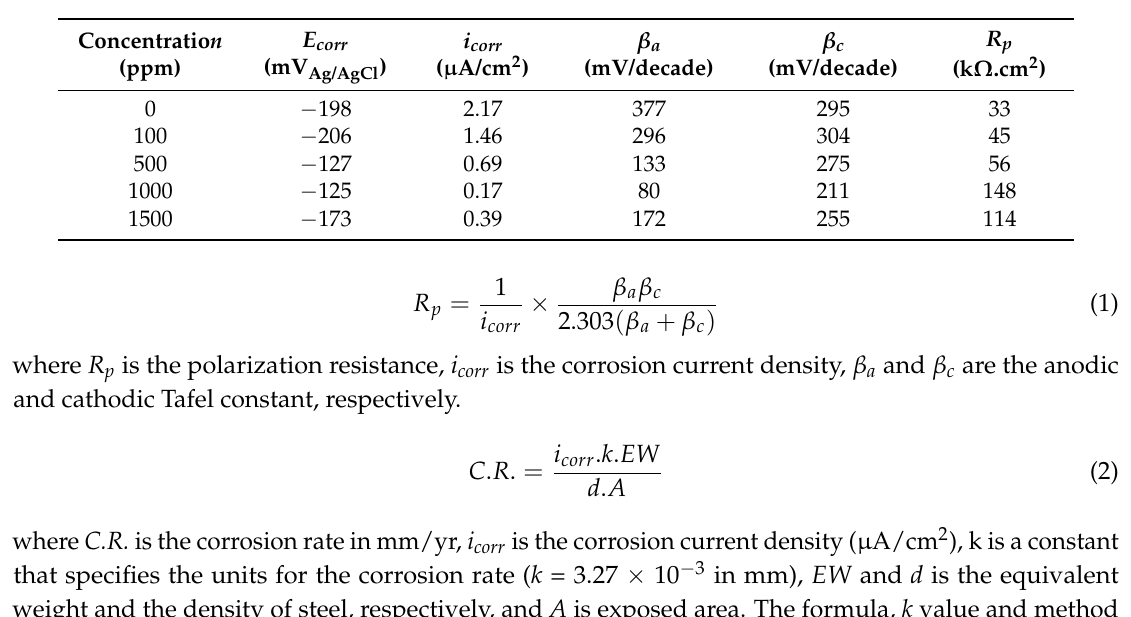
Figure 5. ( a ) Potentiodynamic polarization curves; and ( b ) effect of APL-EAE concentrations on the corrosion rate of steel after 24-hour elapsed for 1 cm 2 immersed in simulated ethanol fuel blend solutions with initial APL-EAE concentrations from 0 ppm to 1500 ppm. Table 4. Corrosion parameters obtained from the potentiodynamic polarization curves of steel after 24-hour immersed in simulated ethanol fuel blend solutions containing different APL-EAE concentrations.